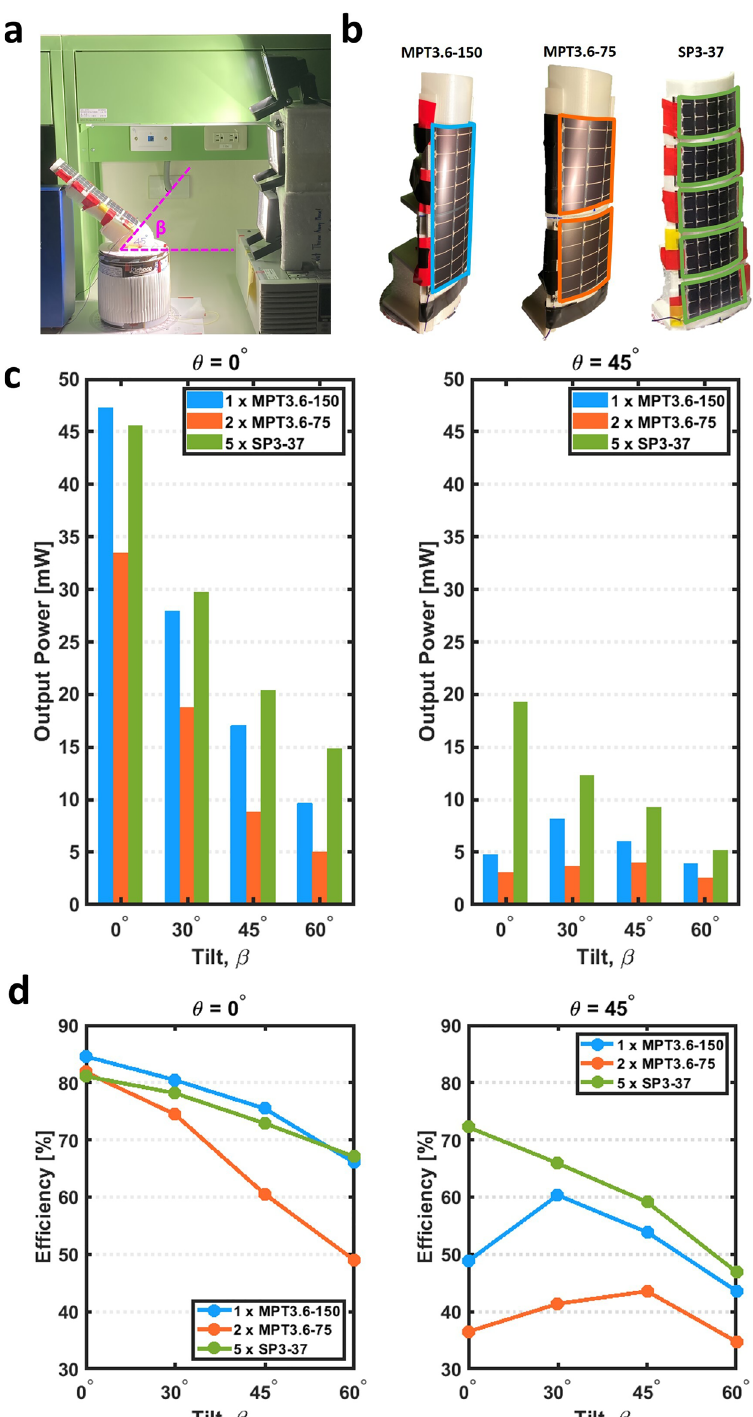
Figure 6. The effect of rotation and tilt on output power. ( a ) A photograph of the forearm test fixture, ◦ sleeve, and halogen lights, with tilt angle of β = 45 . ( b ) A photograph of the single-, double-, and five-panel arrangements on the sleeve. ( c ) The output power generated as the tilt angle changes at rotational angles of 0° (left) and a 45° rotation (right). ( d ) Power efficiency as the tilt angle changes at rotational angles of 0° (left) and a 45° rotation